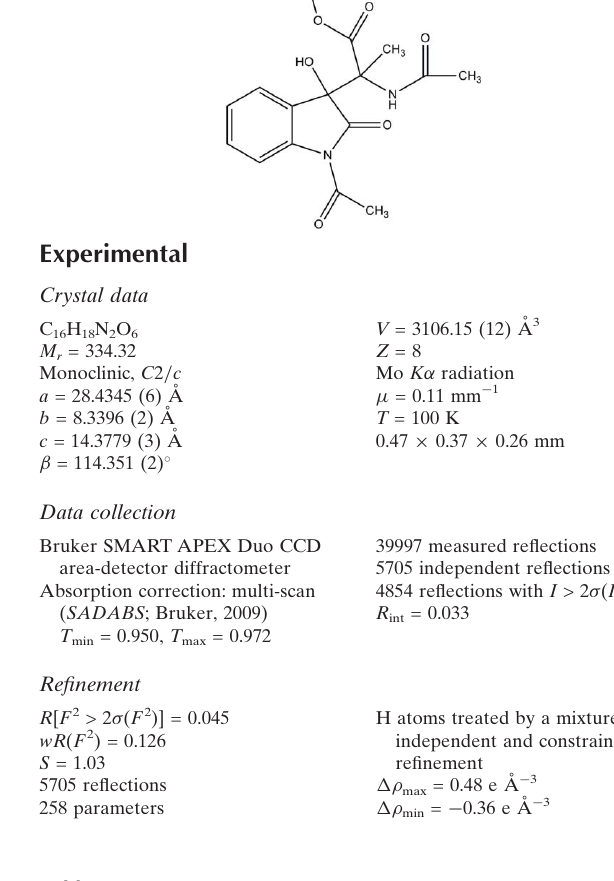
Hydrogen-bond geometry (A˚ , (cid:2) ). Cg 1 is the centroid of the C1–C6 benzene